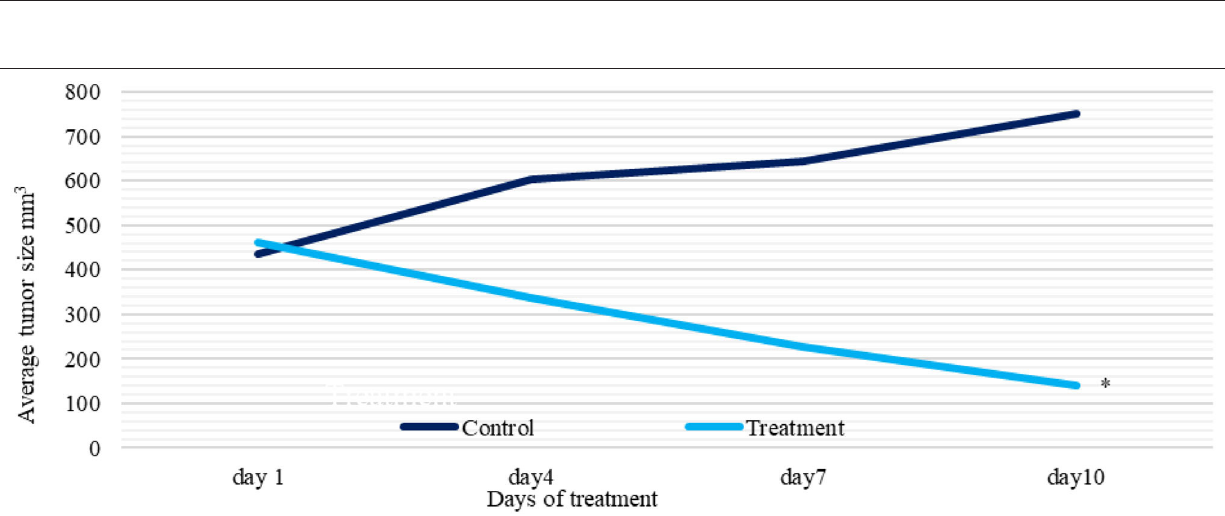
Frontiers in Nutrition |